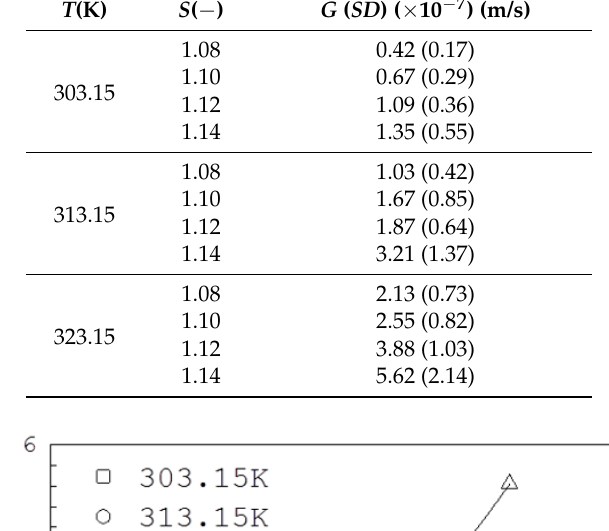
Table 5. The average growth rates and the corresponding standard deviations (SD) for L-Glycine. T (K)